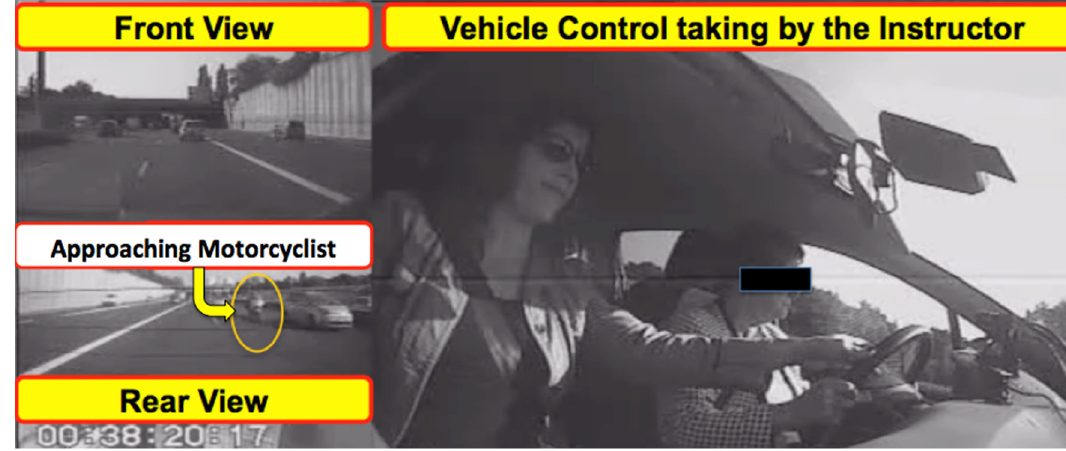
Figure 3. Typical example of driving error during a lane change (on the left ) on highway.